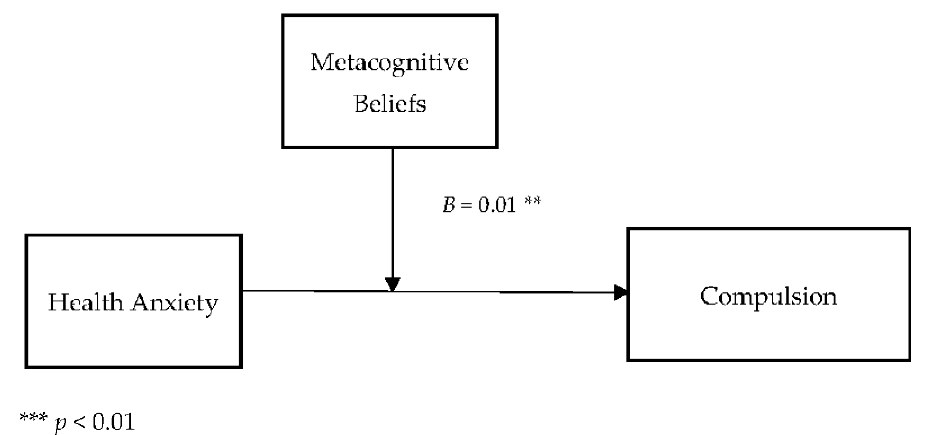
Table 6. Moderation of metacognitive beliefs between health anxiety and distress (cyberchondria construct) ( N = 500).